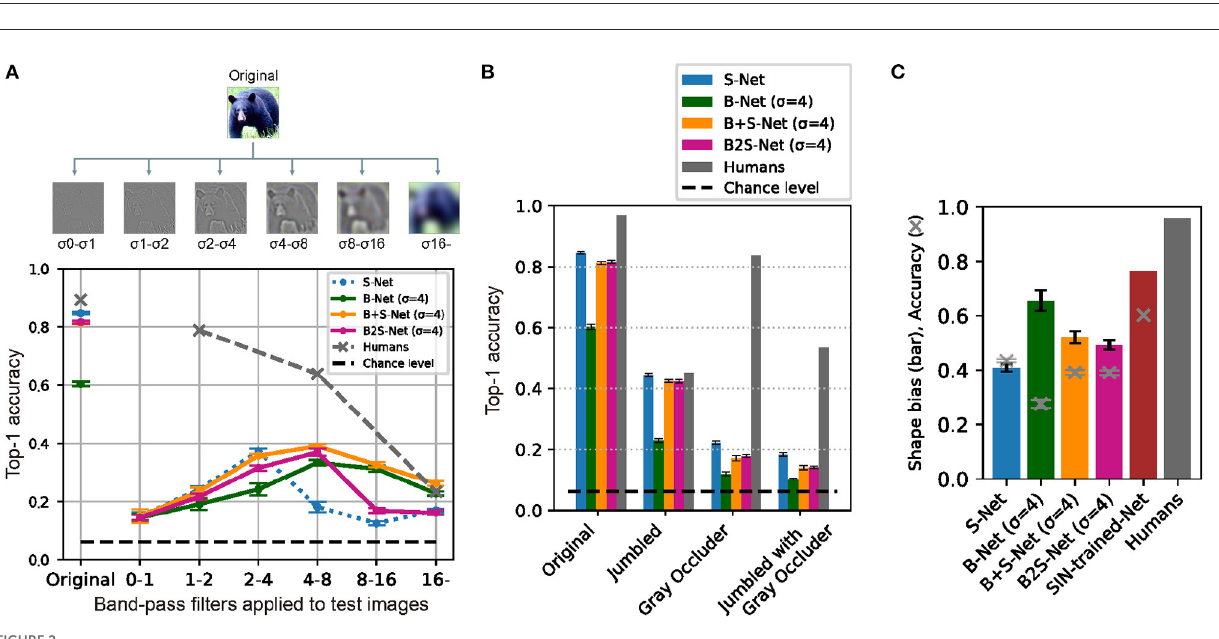
the standard deviation of the Gaussian kernel ( σ ) in the same manner as when we blurred the training images for CNN models. The band-pass images were created by taking the difference between two low-pass images obtained by blurring the same image with